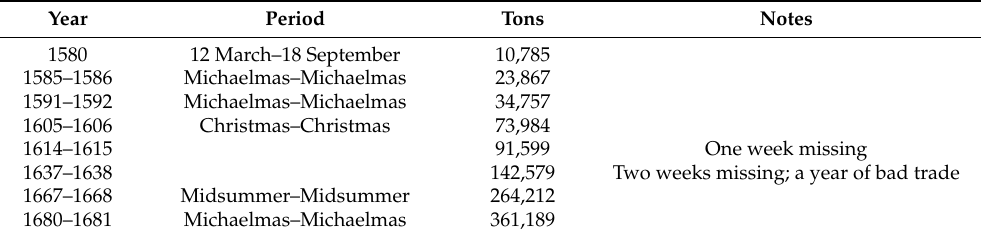
Table 2. Imports of coal into London,